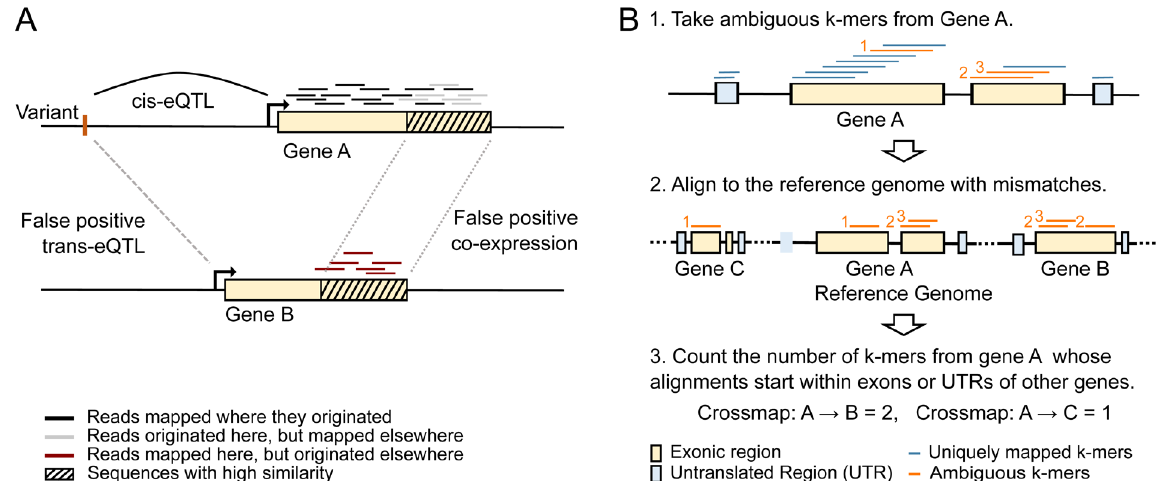
Figure 1. Overview of cross-mappability. A ) Some of the reads generated from Gene A are incorrectly mapped to Gene B because of sequence similarity between the genes, leading to false positive co-expression. Consequently, a variant which is a true cis-eQTL of Gene A appears as a false positive trans-eQTL of Gene B. B ) We align the ambiguous (orange) k -mers (75-mers from exons and 36-mers from UTRs) from Gene A to the reference genome using Bowtie and count how many k -mers from Gene A map to each other gene to compute cross-mappability. Here, the number beside each ambiguous (orange) k -mer represents the identifier for the ambiguous k -mer based on its position in Gene